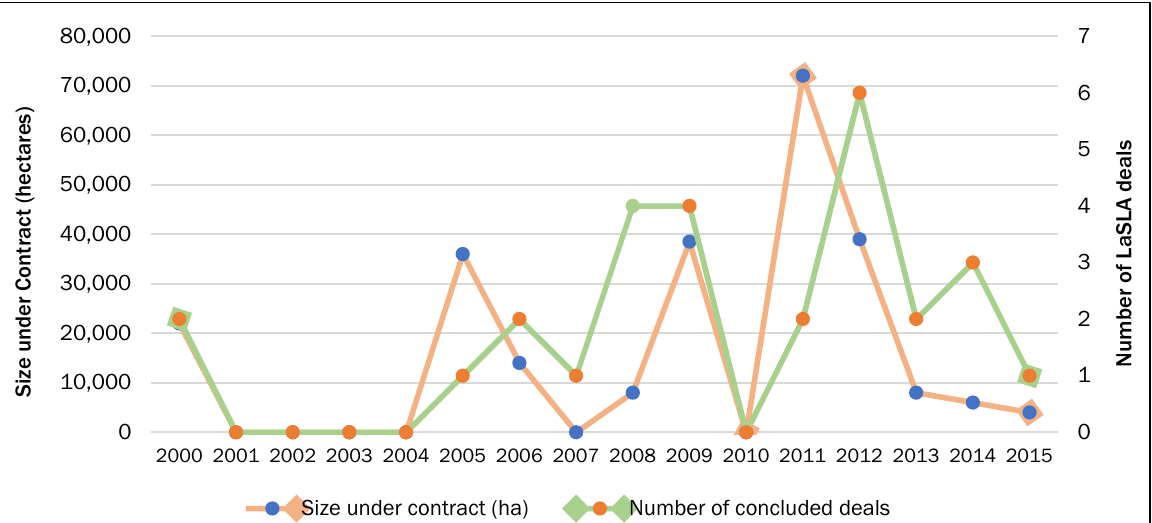
Figure 2. The Number of LaSLA Deals and Land Size Acquired by Investors Between 2000 to 2015 in Tanzania Registered by the Tanzania Investment Centre